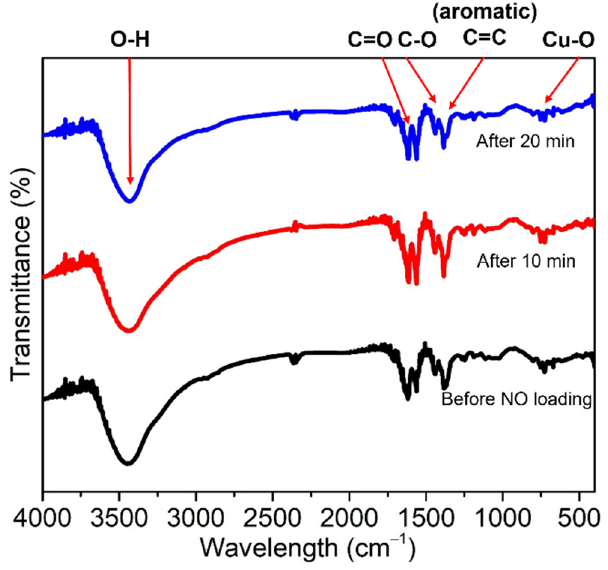
Figure 7. FTIR spectra of 2 (black) and 4 after releasing NO for 10 and 20 min (red and blue, respectively).